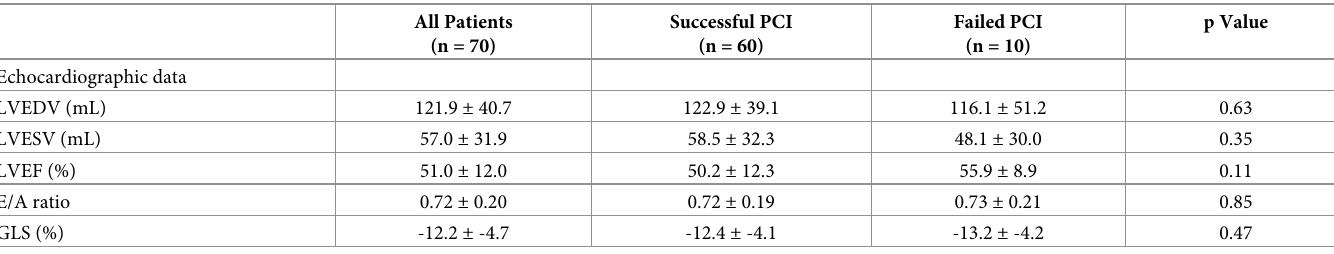
Table 3. Echocardiographic